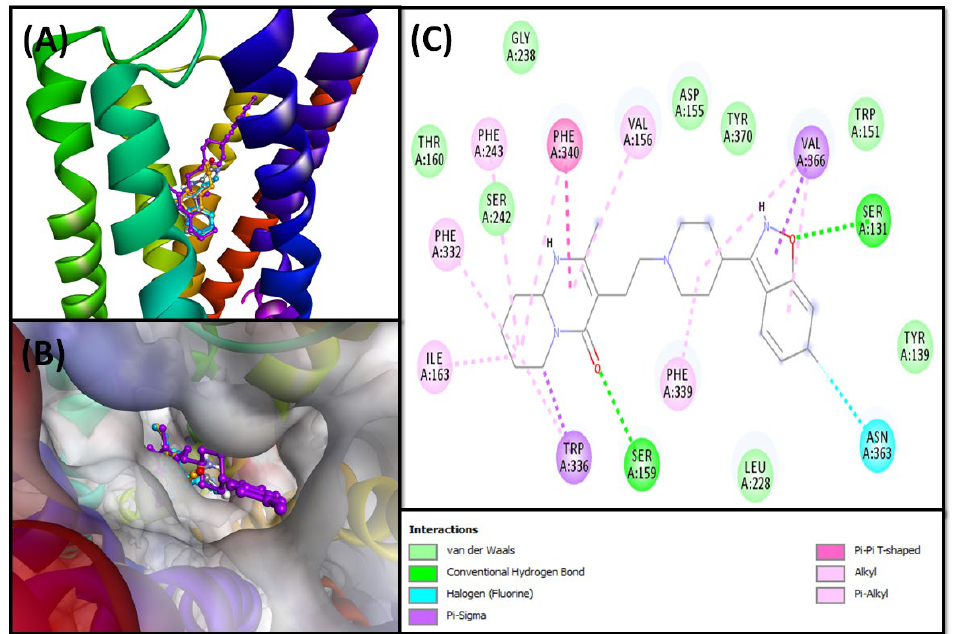
Figure 6. Molecular interaction between SI indole compounds and 5-HT 1A . ( A ) Compound 5 , ( B ) compound 6 , ( C ) compound 7 , and ( D ) compound 8 .